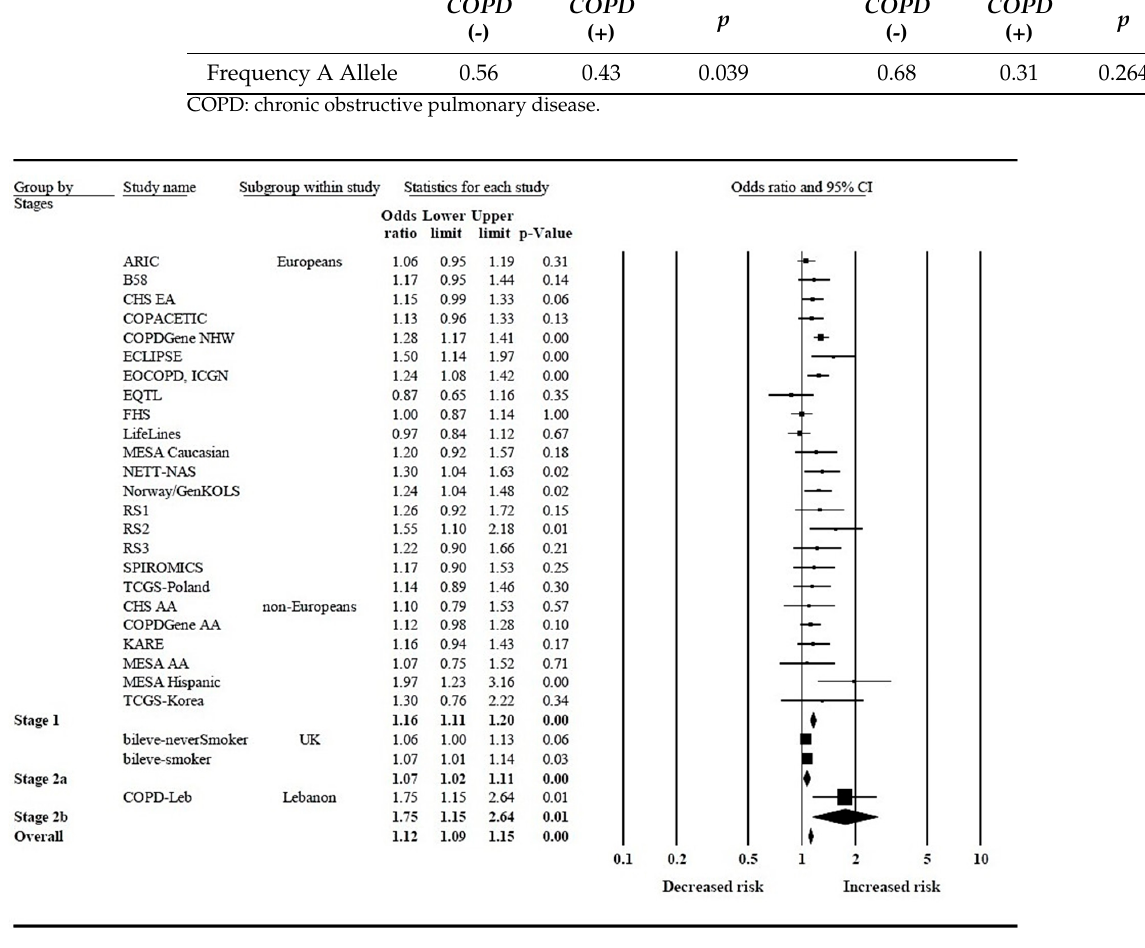
Figure 2. Forest plot for the association of rs6837671 in FAM13A and chronic obstructive pulmonary disease. Stage 1: discovery populations, stage 2a: replication in European populations, stage 2b: replication in non-European populations. Heterogeneity: Tau 2 = 0.005, Chi 2 = 48.720, df = 26 ( p = 0.004); I 2 = 46.6%. Test for overall effect: Z = 7.780 ( p < 0.001).